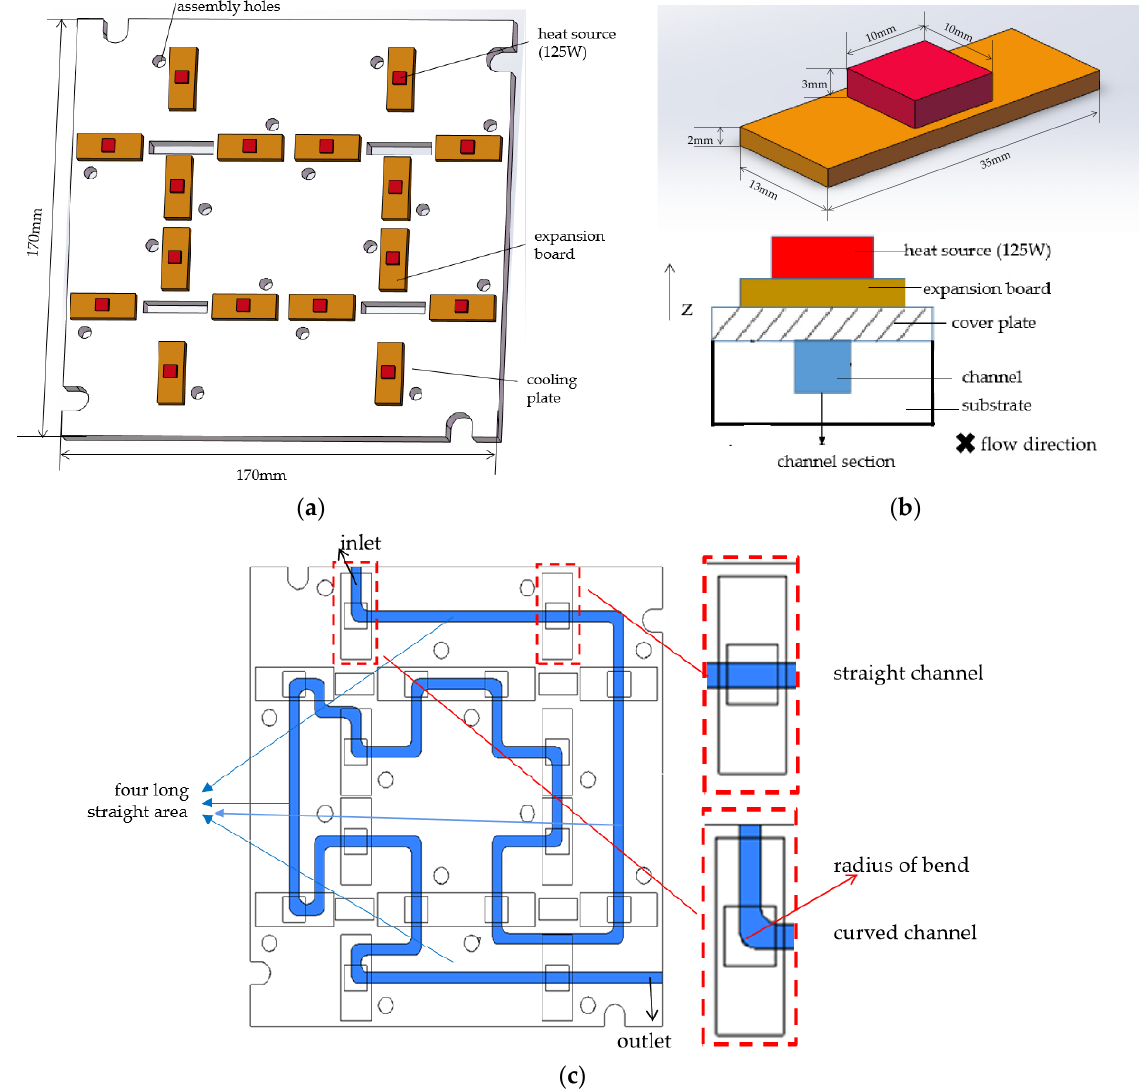
Figure 1. Schematic diagram of: ( a ) heat sink; ( b ) section of heat sink; ( c ) channel. R134a is selected as the refrigerant flowing in the channel. Compared with single-phase flow, two-phase flow forced convection boiling could better satisfy the heat dissipation requirements. To ensure the heat transfer effect, the channel is set just below the heat sources and is already designed for temperature uniformity. The channel is shown